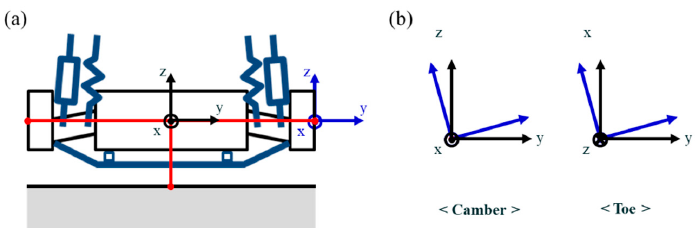
Figure 15. Local coordinate creation and wheel alignment inspection. ( a ) Local coordinate creation. ( b ) Camber and toe angle measurement.